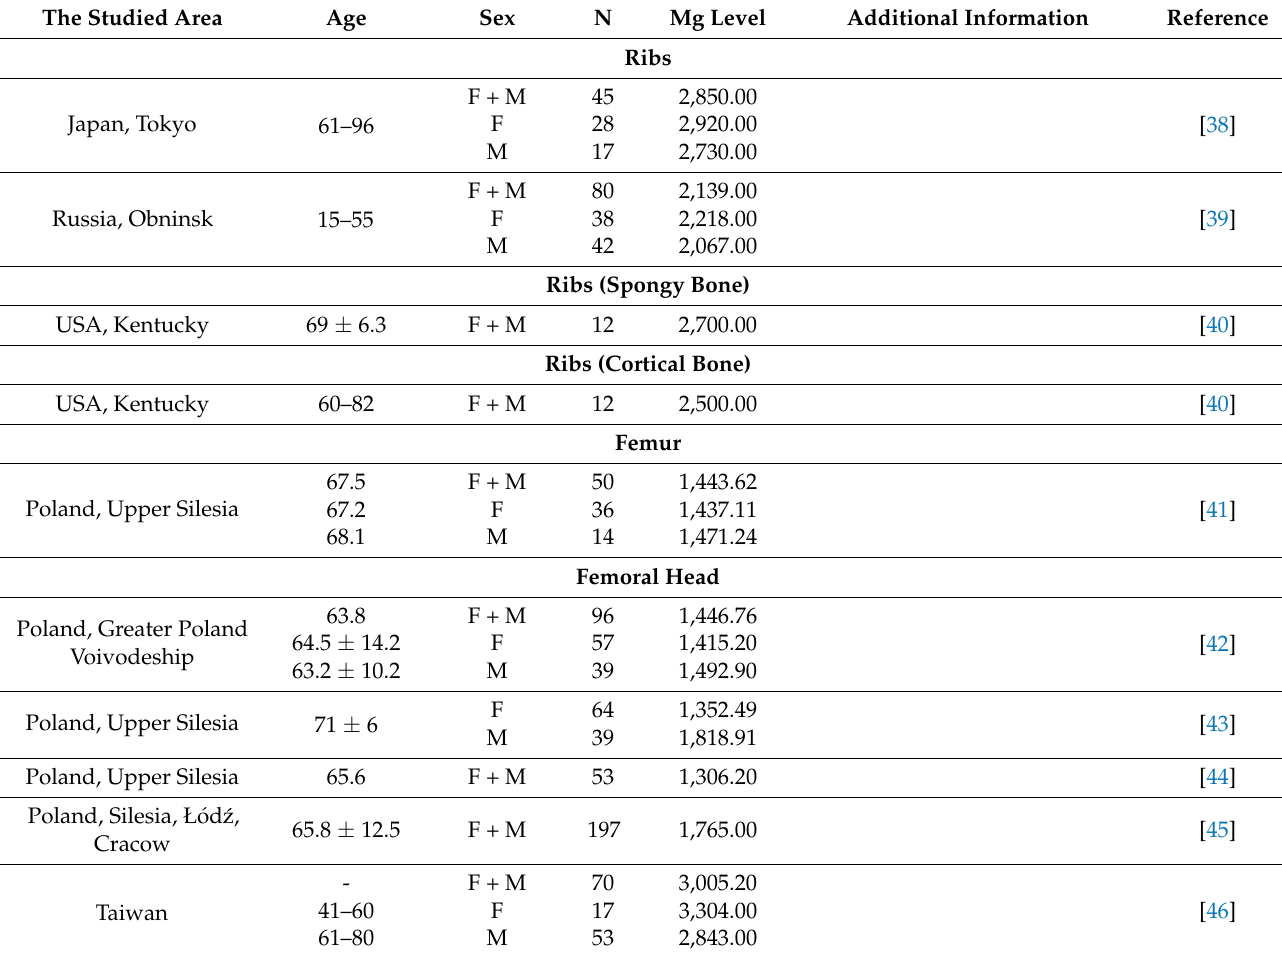
Table 2. Magnesium levels in human bones in mg kg − 1 dw. (F, female; M, male; N, number of participants; NS, nonsmoking; S,